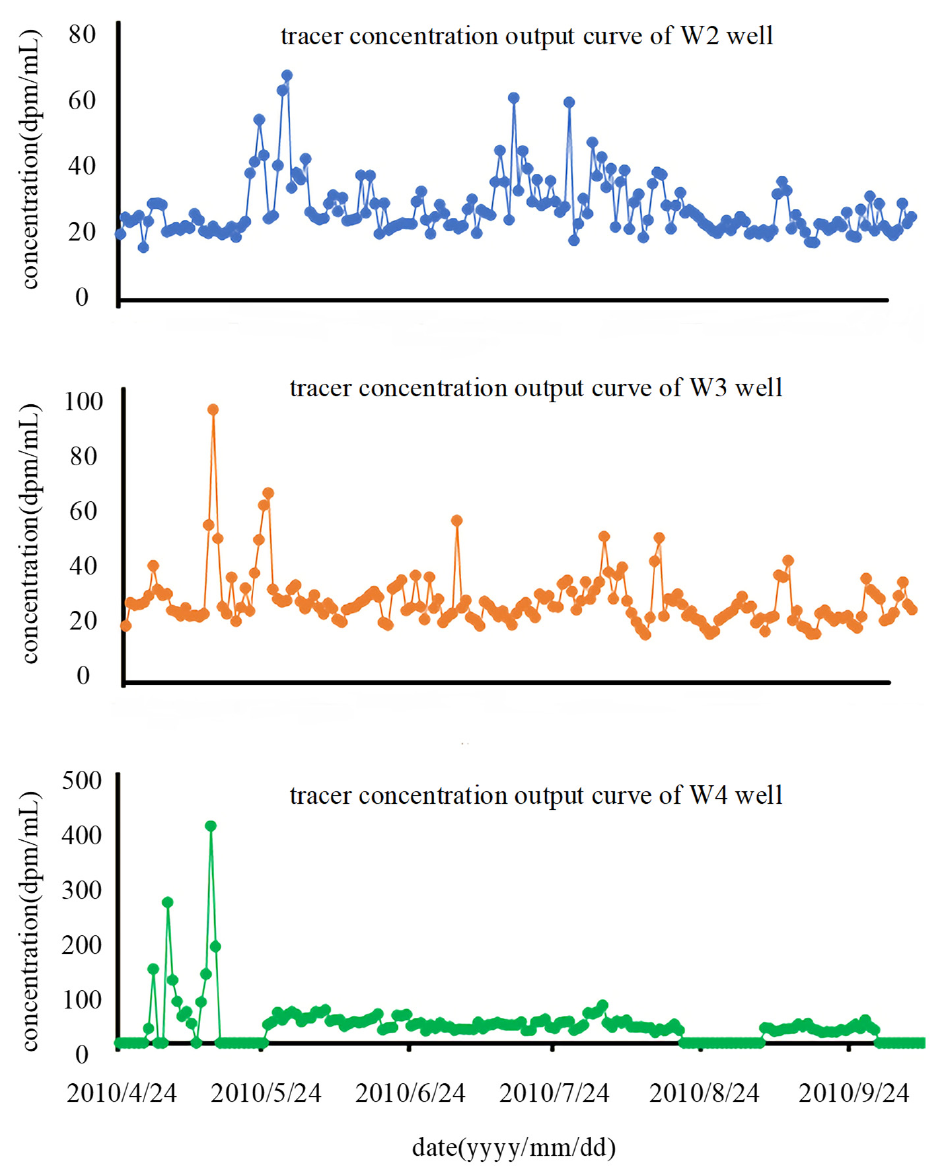
Figure 8. The tracer concentration curve of A well group. Table 4. The tracer test results of A well group.